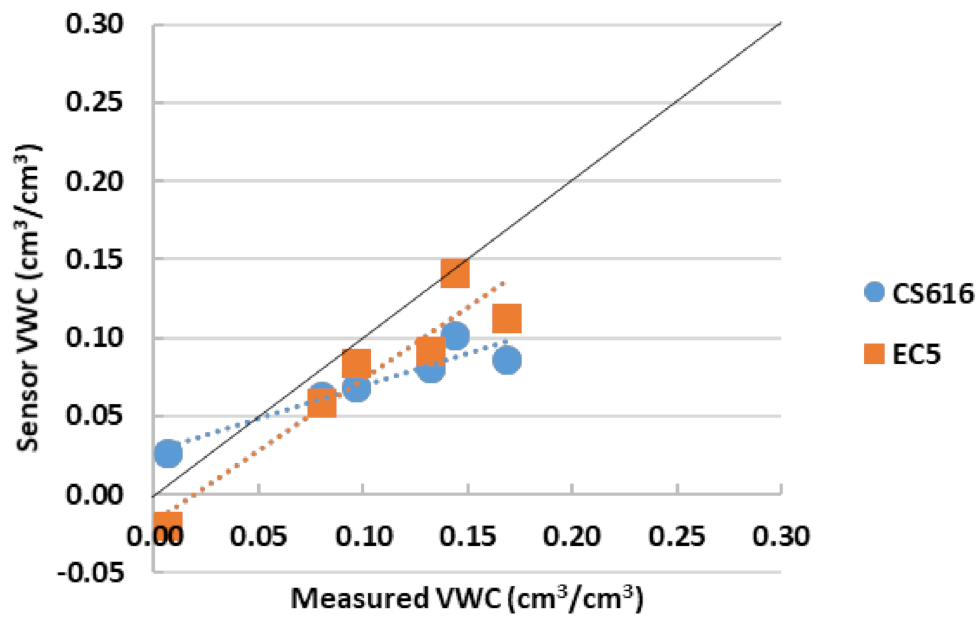
Figure 3. Comparison of CS616 and EC5 with soil sampling method for loamy